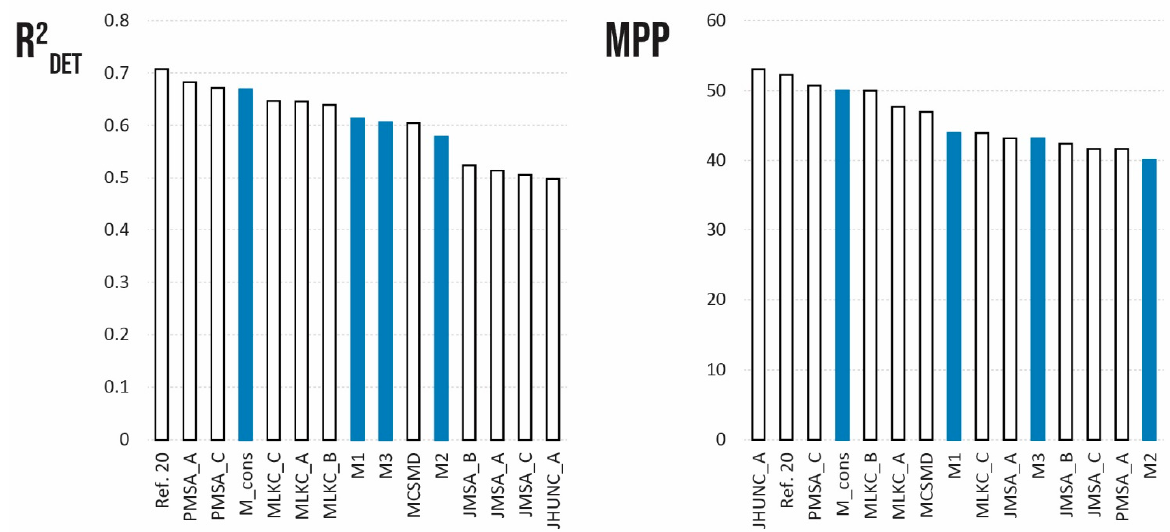
Figure 4. Comparison of Solubility Challenge 2019-submitted best models, consensus model (M_cons)